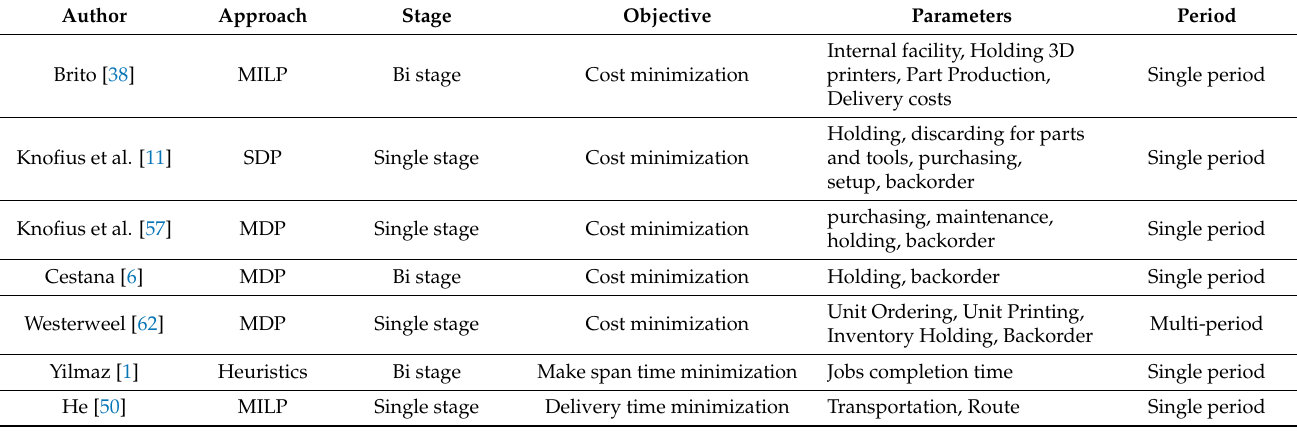
Table 3. Approach, stage, objective, parameters, and period for optimization quantitative methods.